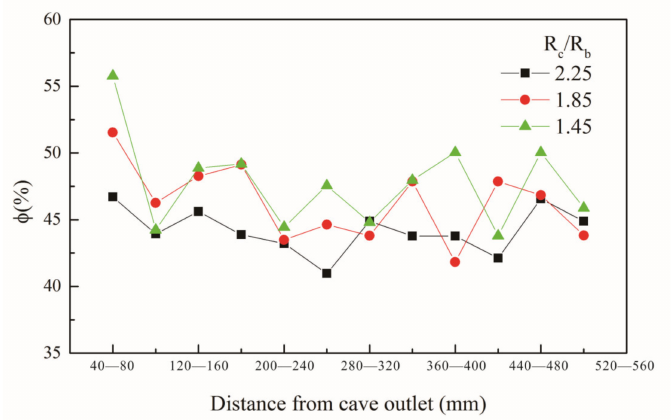
Figure 15. The vertical variation of the porosity of the porous medium formed in the first-stage